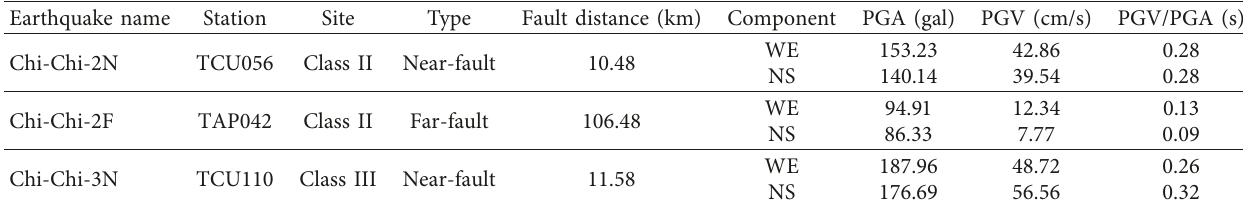
Table 2: Earthquakes records used for test